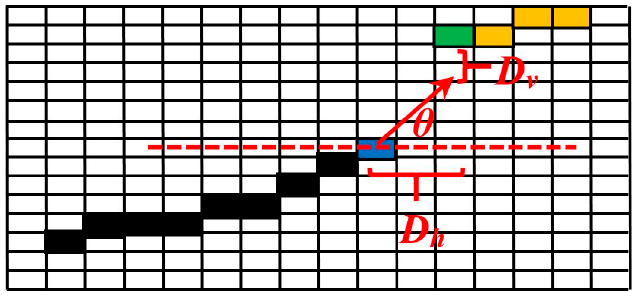
Figure 6. Illustration of horizon linking. The blue point is the endpoint of a horizon segment, and the green point is the point that requires linking. The yellow and black points represent horizon points of different horizon segments. The red arrow represents the direction information of the blue point.